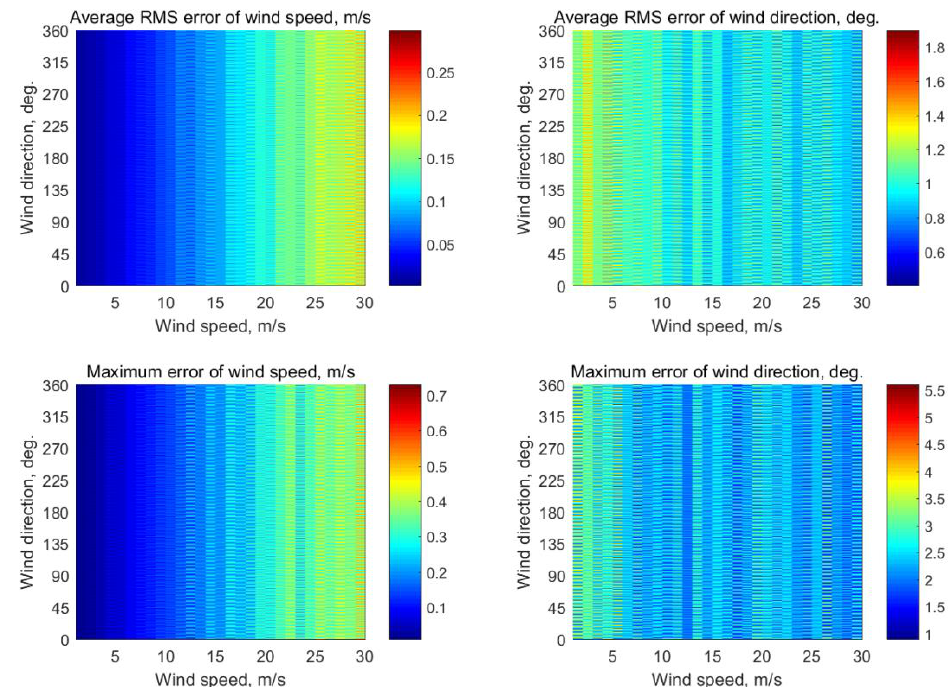
Figure A5. Simulation results of the use of only one incidence angle of 50° for wind retrieval.